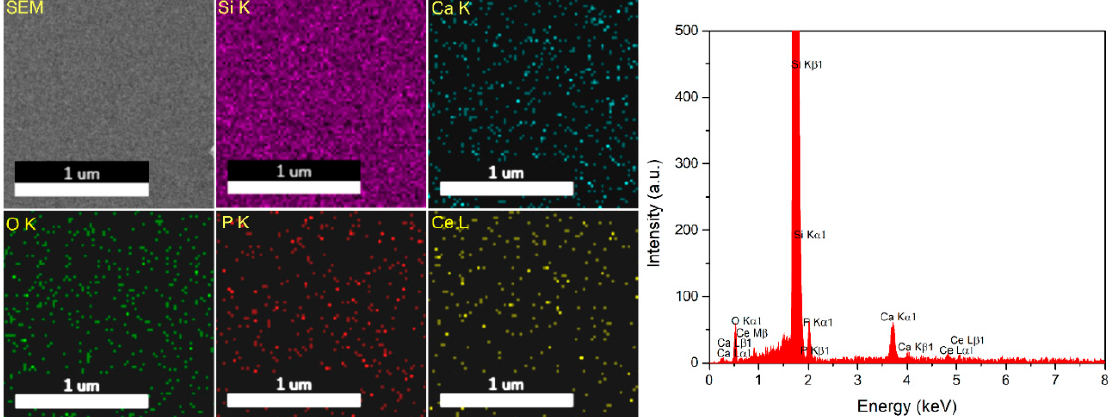
Figure 5. EDS cartography of 10Ce-HAp coating and typical EDS spectrum of 10Ce-HAp coating.